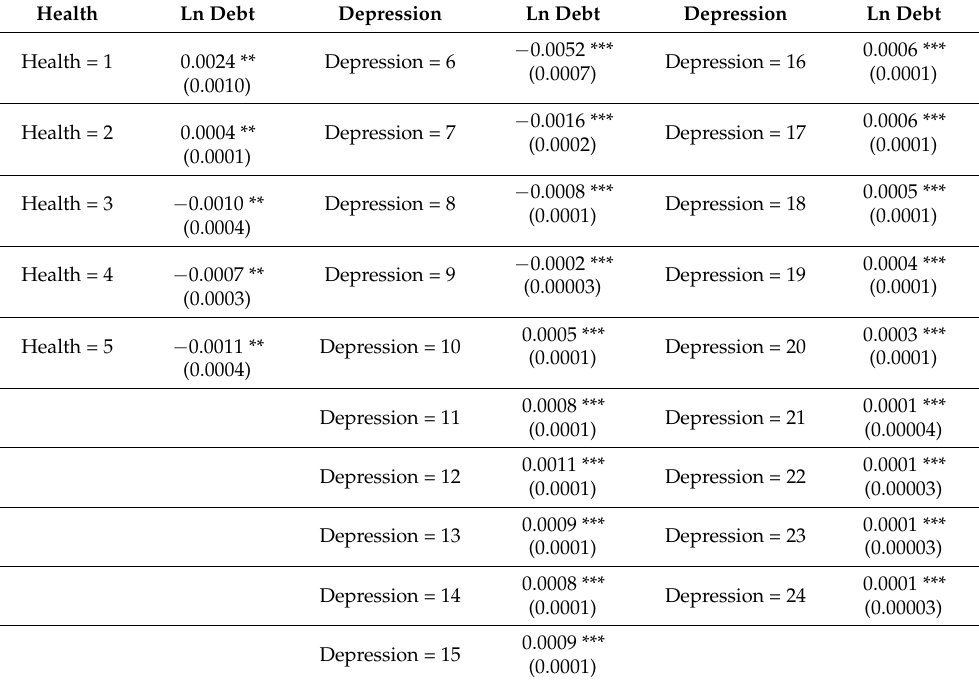
Table 4. The marginal effects of household debt on the health of the